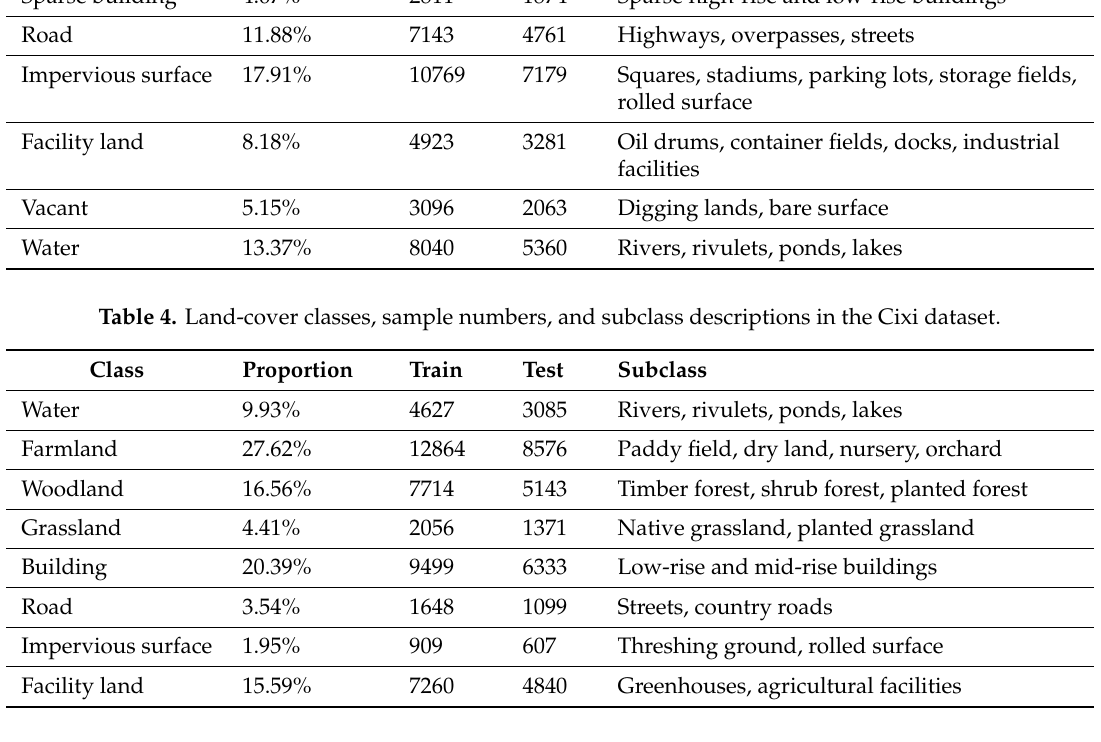
Table 5. Land-cover classes, sample numbers, and subclass descriptions in the Xiaoshan dataset.